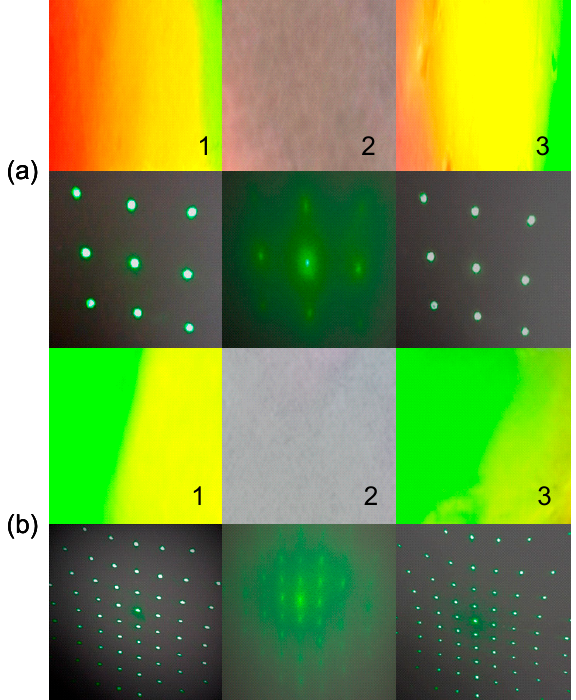
Figure 6. Digital photographs and laser diffraction patterns of the ( a ) 2A and ( b ) 4B microstructured PETMP-TTT films: (1) imprinted, (2) after deformation, (3) after recovery.